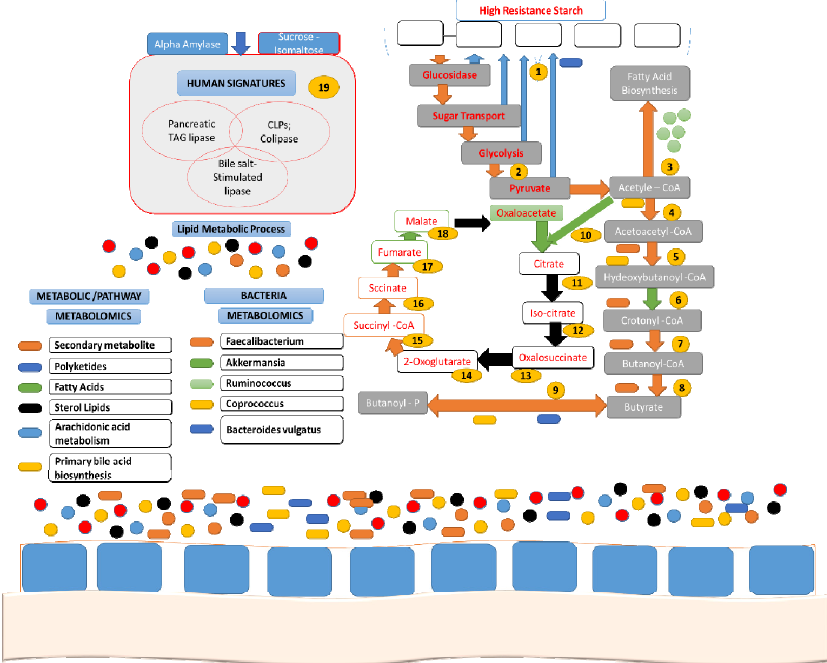
Figure 4. Summary of distinguished enzymes, subsequent pathways, particular species, and specific metabolites that are expressively obstructed through a high resistant starch (HRS) diet. Blue arrows / frames, increased with HRS; orange frames, decreased with HRS; black arrows, not detected or not increased with HRS over baseline; green arrows / frames, increased with low resistant starch (LRS). 1, starch and metabolism of sucrose; 2, glucose to pyruvate leads to glycolysis pathway; 3, 3-